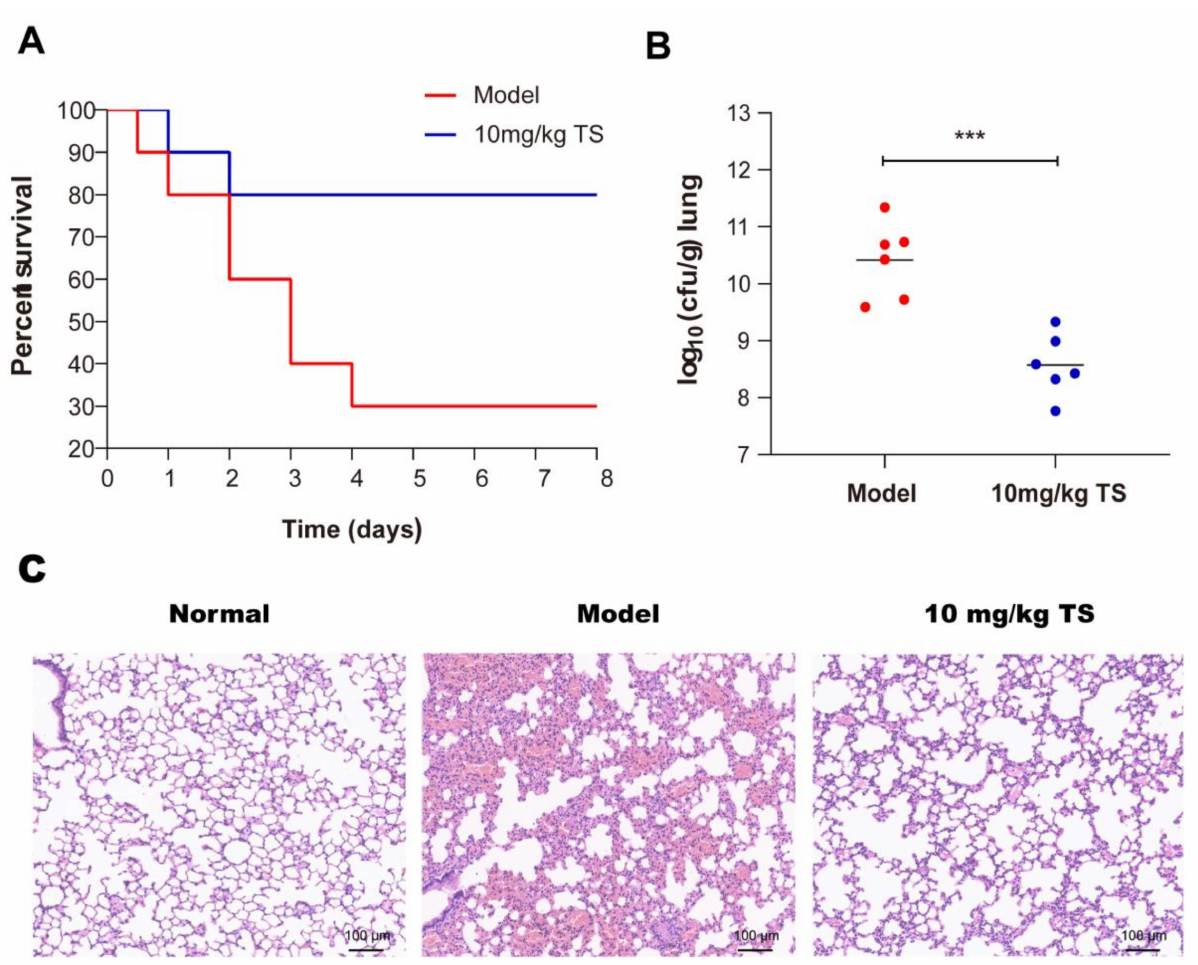
Figure 6. Antimicrobial peptide TS protects mice infected with E. coli ATCC 25922. ( A ) Survival rates for the E. coli ATCC 25922 pneumonia model. ( B ) Bacterial loads of the lungs of TS-treated E. coli ATCC 25922-infected mice were examined at 24 h after infection. ( C ) H&E staining was used to detect lung morphologies of the E. coli ATCC 25922 pneumonia model after TS treatment. *** p <